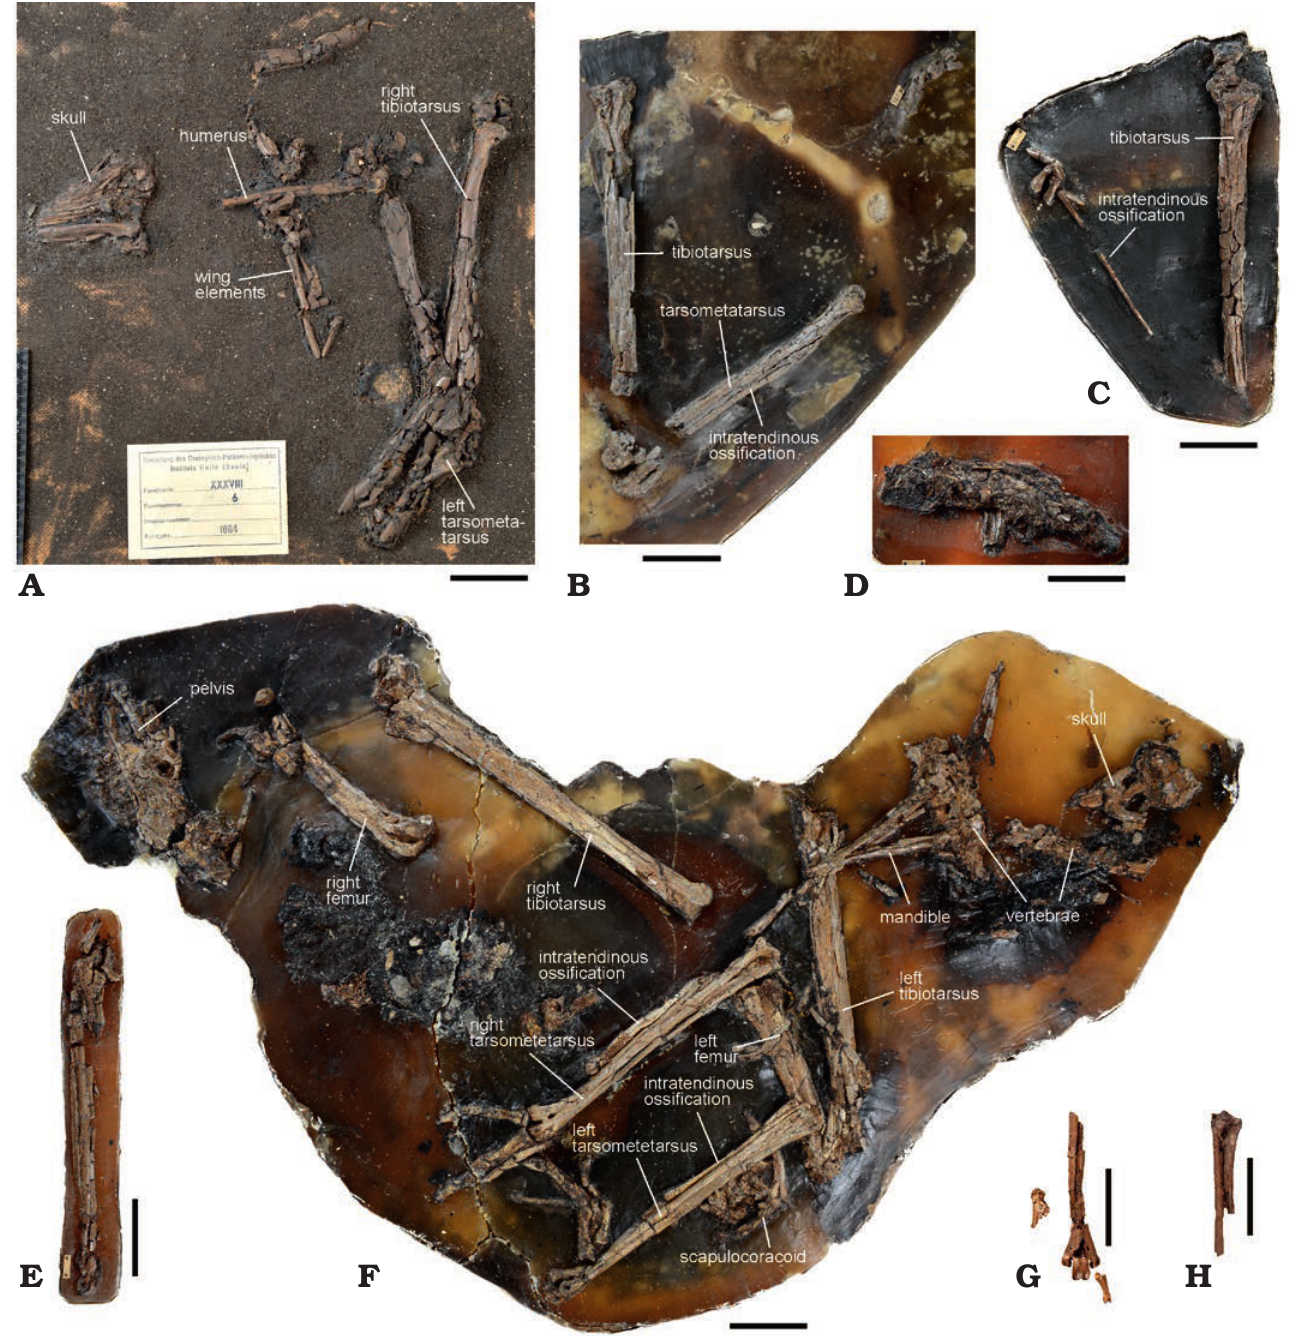
Fig. 1. Fossils of the palaeotidid bird Palaeotis weigelti Lambrecht, 1928, all specimens are from the middle Eocene of the Geiseltal, Germany. A . GMH XXXVIII-6-1964, partial skeleton. B . GMH 5882, right tibiotarsus and tarsometatarsus; holotype of Palaeogrus geiselta lensis . C . GMH 3402, tibiotarsus lacking distal end, intratendinous ossification, and pedal phalanges. D . GMH 4363, pelvis. E . GMH 4361, tarsometatarsi. F . GMH 4362, partial skeleton. G . GMH 4415, 4416, 4418, holotype: distal end of left tarsometatarsus, pedal phalanx, and possible wing phalanx. H . GMH IX-566-1953, proximal end of right tarsometatarsus. Scale bars 50